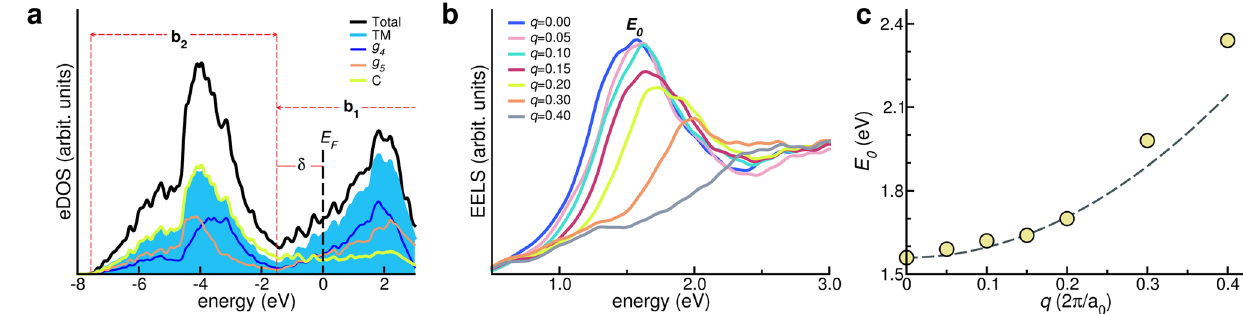
Fig. 4 | Optical properties of plasmonic 3-HfNbTaTiZrC 5 system. a Total (black area), TM- (cyan area), g 4 -(thin blue line), g 5 -(thin orange line) and C-projected (thick green line) eDOS. Zero energy reference is set to the Fermi level ( E F ). b 1 , b 2 and δ indicate the band manifoldsand the energy difference discussedinthe text.